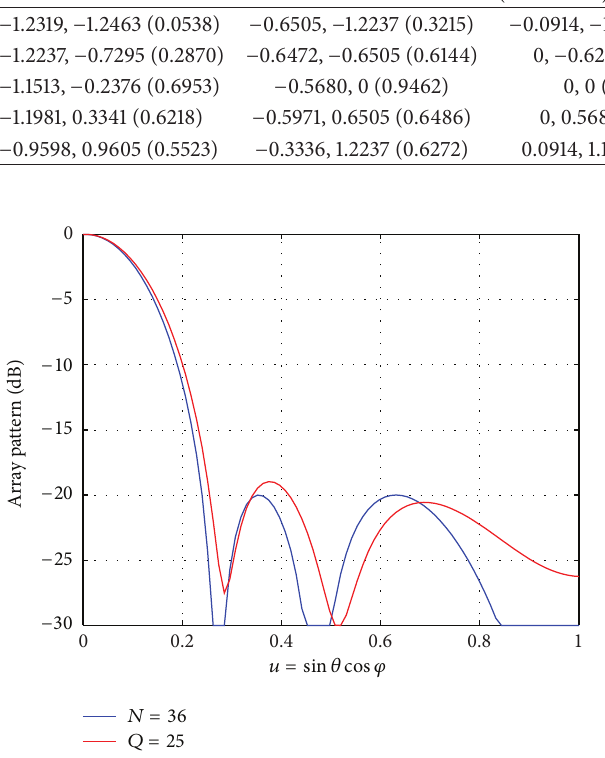
Figure 6: The cross section of the pattern.